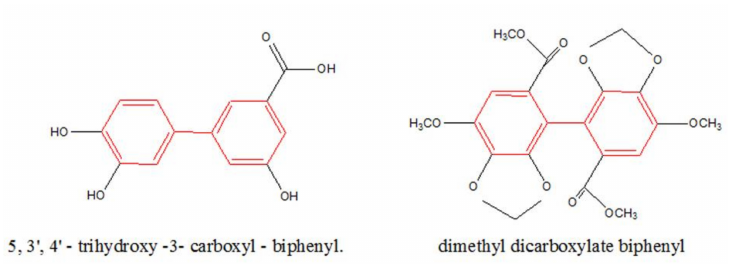
Figure 3. The biphenyl skeleton in compound ( 1 ) and dimethyl dicarboxylate biphenyl